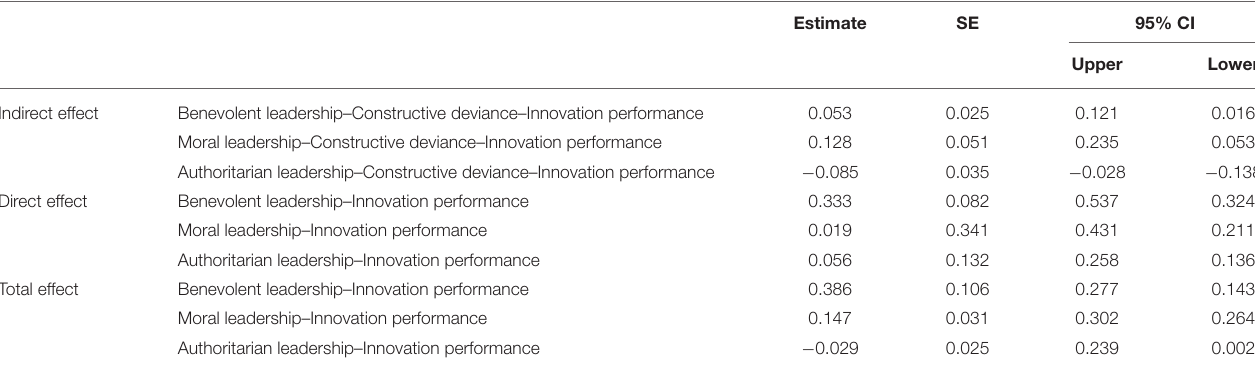
TABLE 4 | The result of mediating